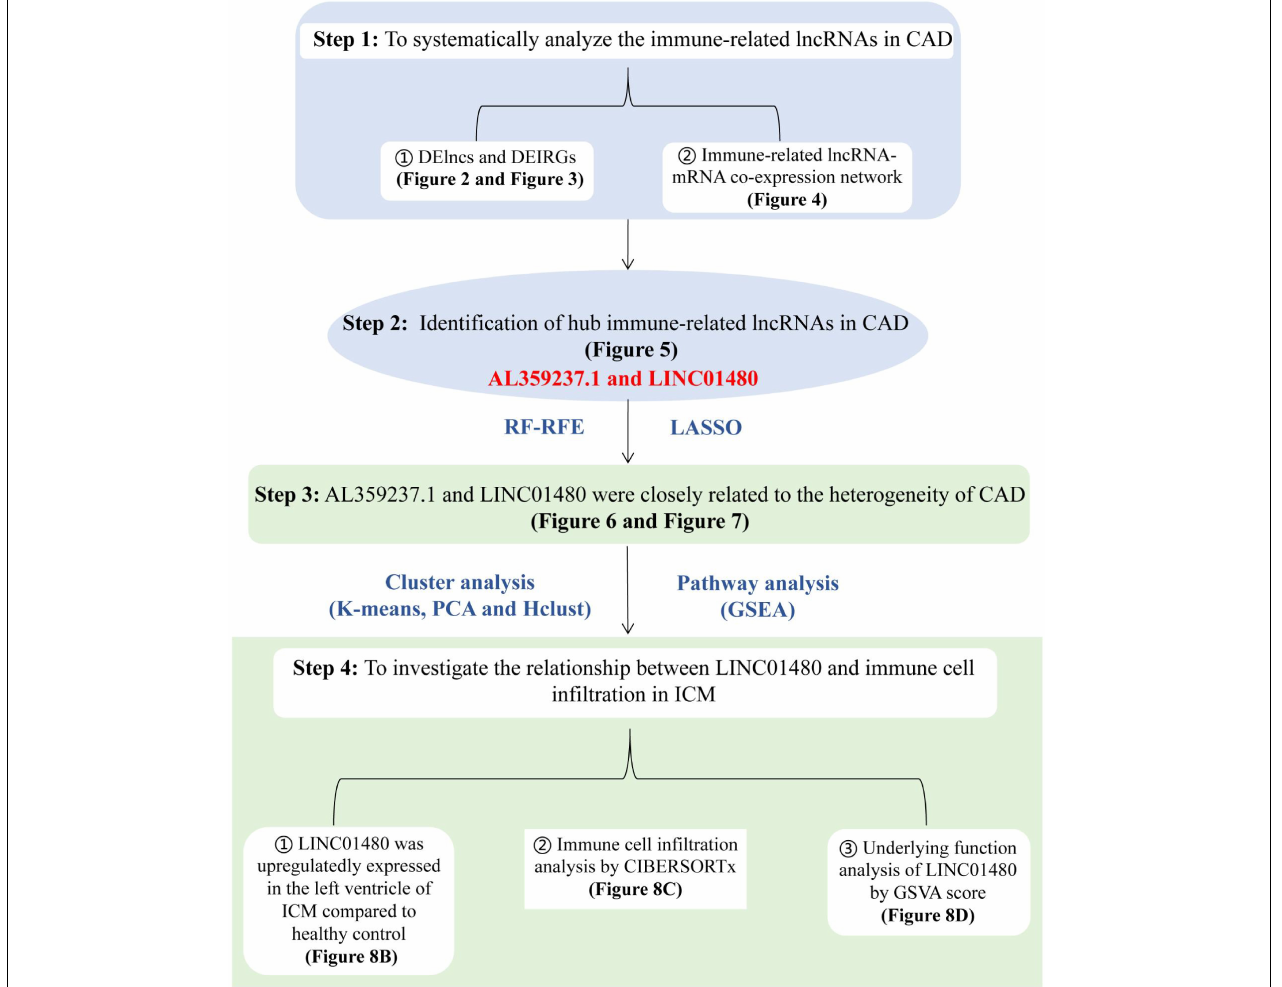
FIGURE 1 | Flowchart of the data analysis. The analytical procedure for step1 to step3 was performed based on the microarray dataset [GSE113079, derived from PBMCs of coronary artery disease (CADs) and healthy controls], and the analysis of step4 was based on the RNAseq datasets (GSE48166, GSE116250, GSE46224, GSE120825, derived from left ventricles of ICMs and healthy controls). CAD, coronary artery disease; ICM, ischemic cardiomyopathy; DELncs, differentially expressed long non-coding RNAs; DEIRGs, differentially expressed immune-related genes; lncRNA, long non-coding RNA; mRNA, messenger RNA; RF-RFE, random forest-recursive feature elimination; LASSO, the least absolute shrinkage and selection operator; PCA, principal component analysis; Hclust, hierarchical clustering; GSEA, gene set enrichment analysis; GSVA, gene set variable analysis; RNAseq, RNA